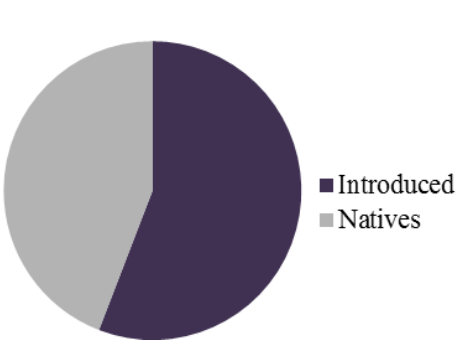
Figure 3. Percentage contribution of introduced and native plant species in the area of the Itata estuary (Bío-Bío Region,